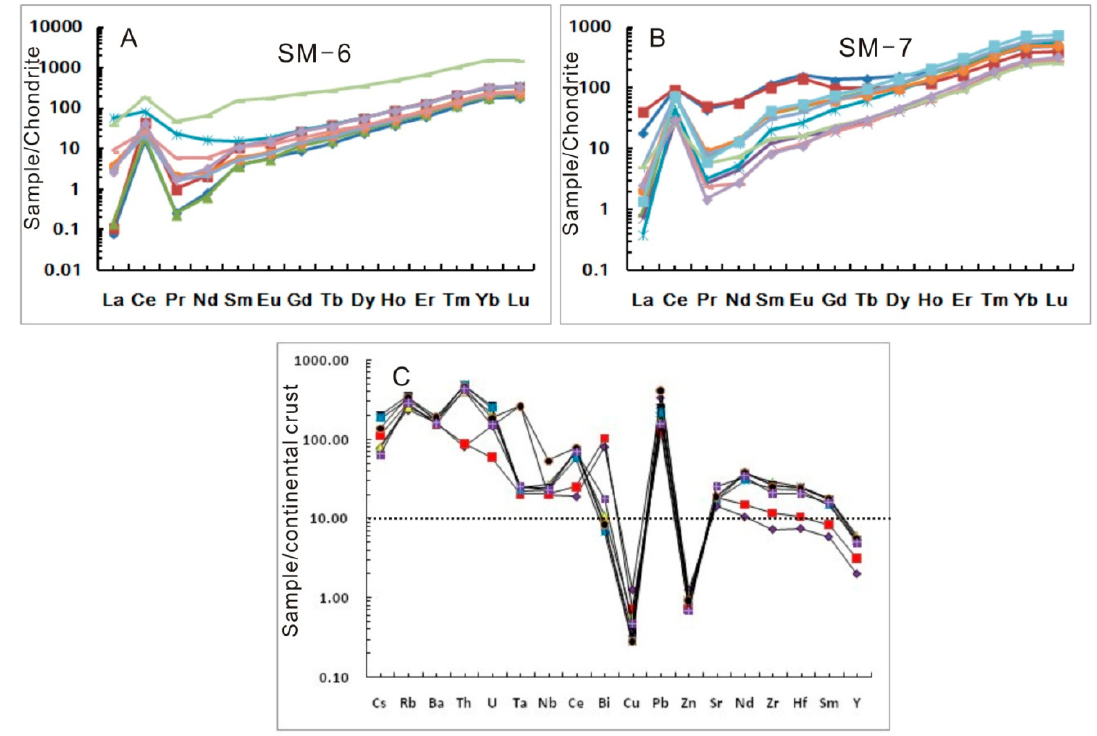
Figure 9. Chondrite-and average continental crust normalized REE distribution diagrams for different zircons from the BA Sin the studied area. ( A , B ) Chondritenormalized REE distribution. ( C ) Average continental crust normalized REE distribution. The chondrite values are from [33,34]. The Northern and Southern Accretionary Orogens. The average continental crust is from Eizenhöfer et al. [32].